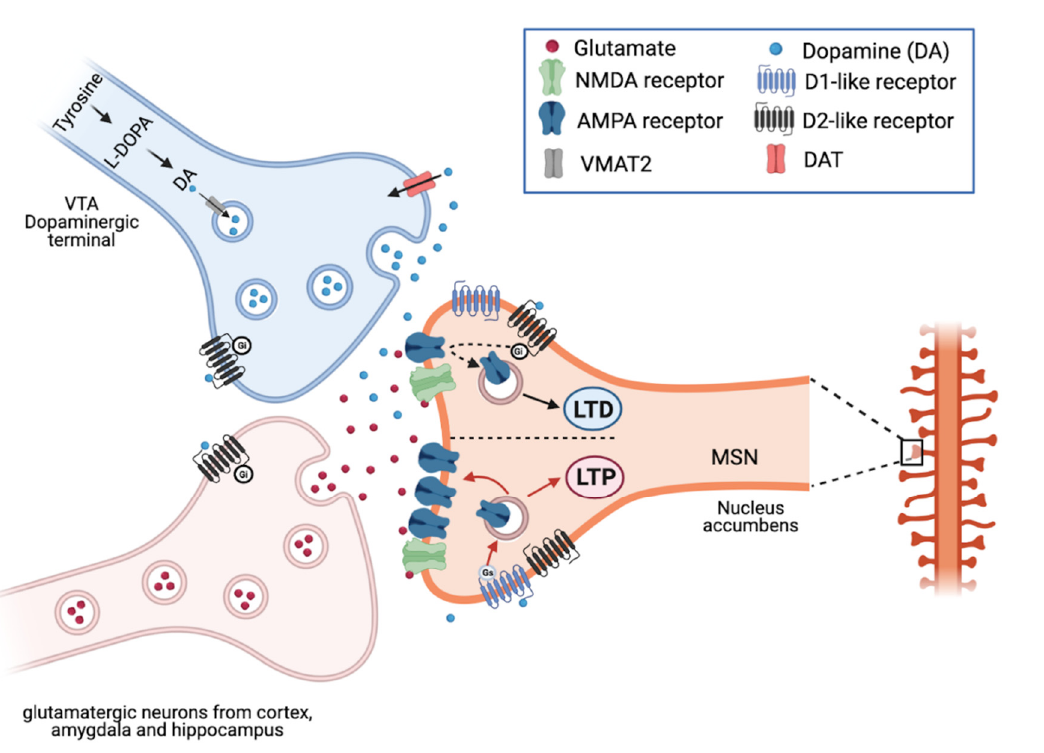
Figure 2. Medium spiny neurons of nucleus accumbens (nAc) receive glutamatergic inputs from medial prefrontal cortex (mPFC) hippocampus and amygdala (Amy) and DAergic inputs from VTA. Glutamate acts on glutamate receptors